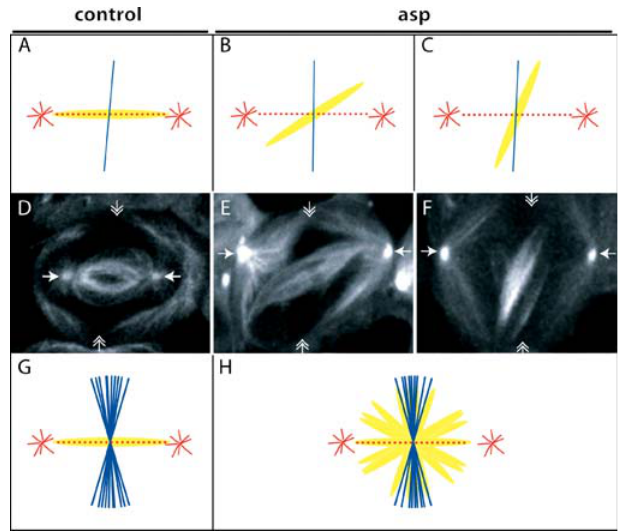
Figure 6. Correlation between the Orientation of the Cytokinesis Furrow, the Asters, and the Spindle in asp Spermatocytes Schematic representation (A–C) of the relative position of the asters (red), the spindle (yellow), and the cytokinesis furrow (blue), corresponding to a control cell (D) and two examples of asp mutant spermatocytes (E and F), respectively. Asters (arrows) and spindles are labelled with a GFP– a -tubulin fusion. The position of the cleavage furrow (double-headed arrow) was determined by time-lapse imaging of these cells (data not shown). In wild-type cells ( n = 10), plotting spindle and furrow orientation relative to the interastral axes shows that asters and spindle are tightly aligned, and cleavage occurs at an angle of 90 8 6 10 8 with respect to them (G). In asp spermatocytes ( n = 10), the plane of cleavage occurs at a 90 8 6 10 8 angle with respect to the asters and does not correlate with the orientation of the anastral spindle. DOI: